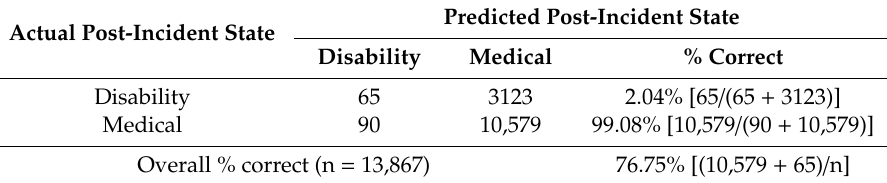
Table 4. Classification table for the LR